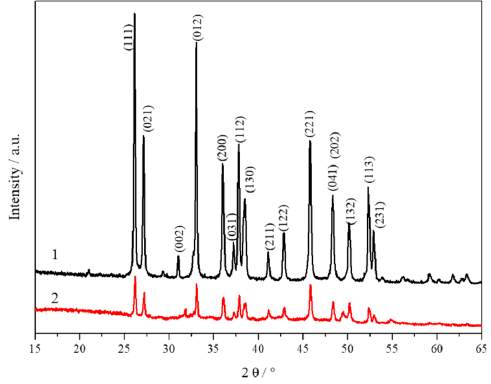
Figure 3. X-ray diffraction patterns (1) CCNPs; (2) mussel shells powder.